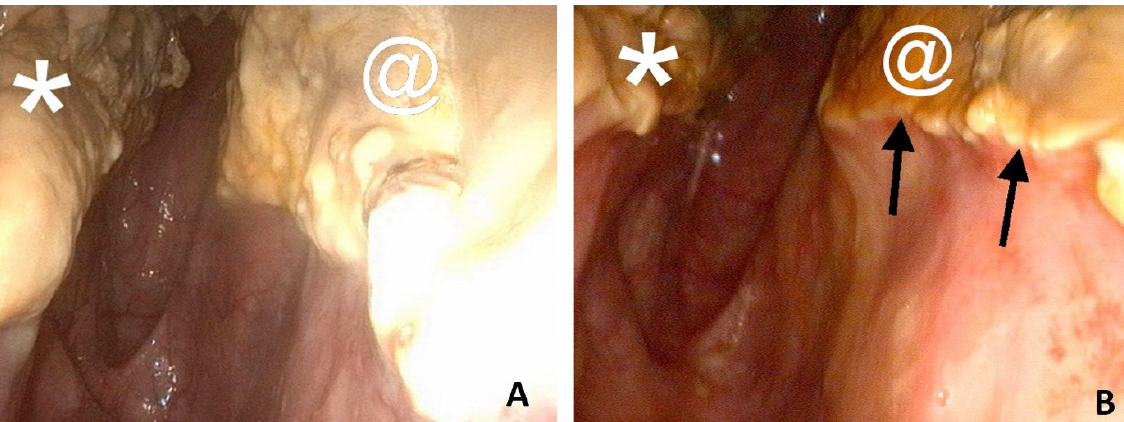
Figure 5. Endoscopic evaluation of Horse 5’s right GP (guttural pouch): ( A ) at admission before a TACE (transarterial coil embolization) procedure. Macroscopic inflammatory lesions are located in the medial ventral compartment involving the stylohyoid bone (*) and the median septum (@); ( B ) after 7 days of TOT (topical oxygen) and a TACE procedure, the volume occupied by the lesions located on the septum reduced and a scar line developed on the periphery (black arrows).